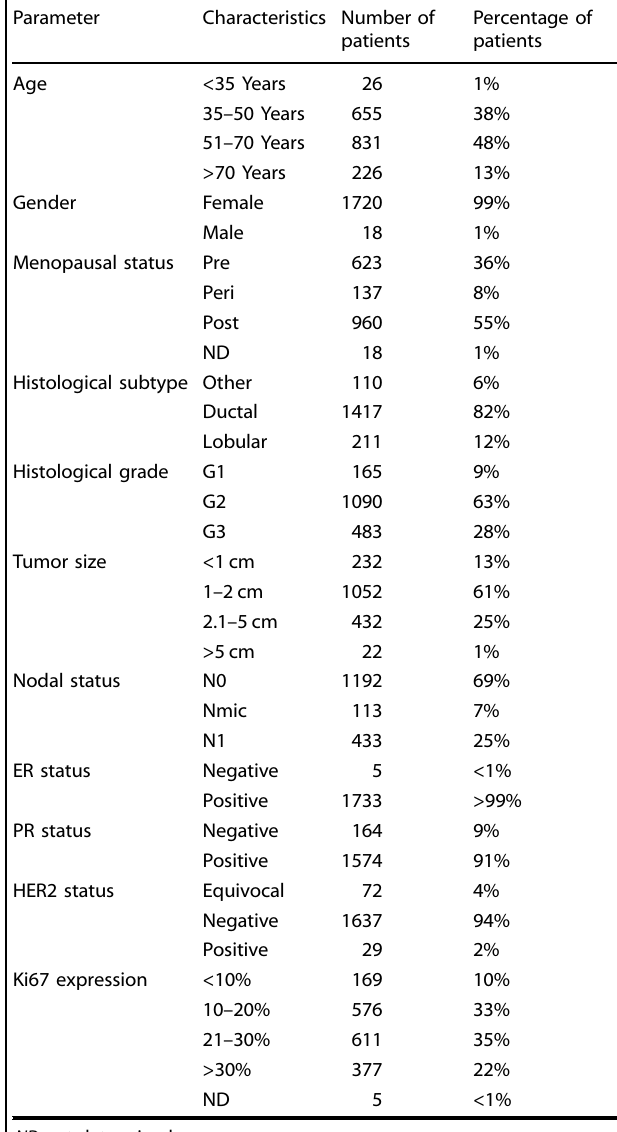
TABLE 1. Patient and tumor characteristics in the overall population ( N =